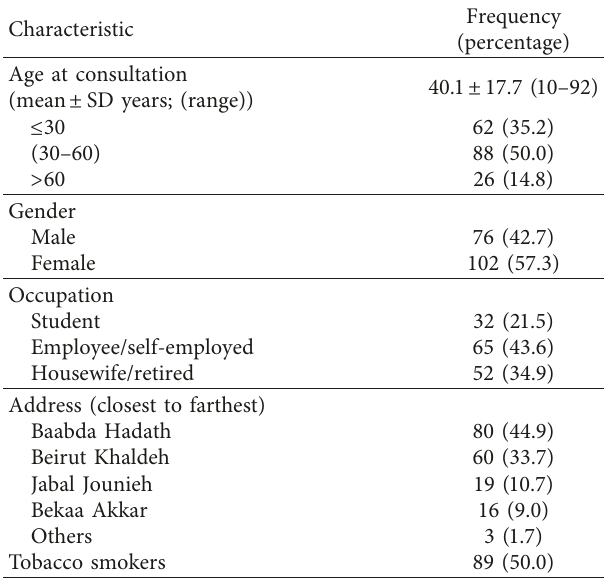
Table 1: Total sample description ( n �